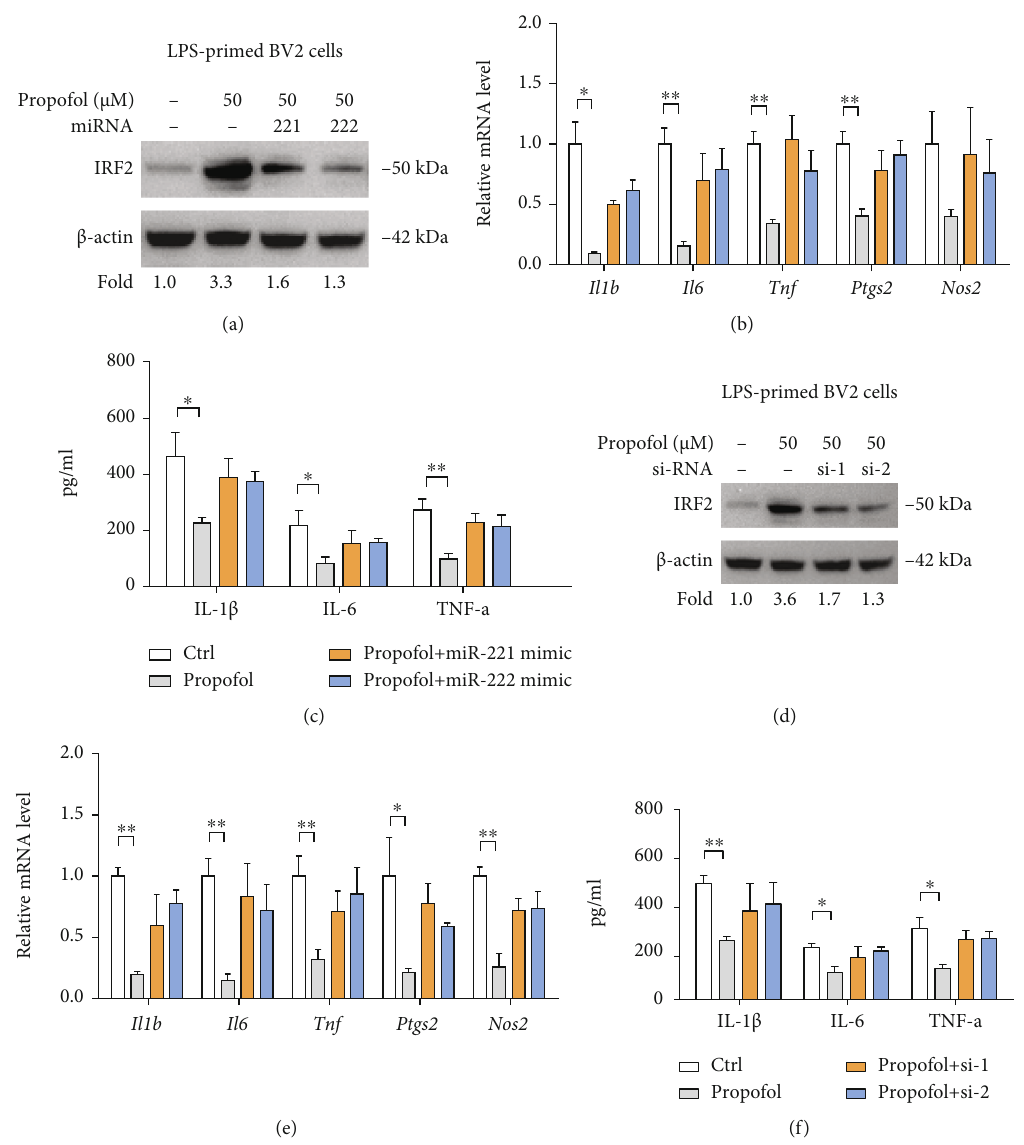
Figure 5: Propofol suppresses BV2 activation via targeting miR-221/222-IRF2 axis. (a) IRF2 protein expression in LPS-primed BV2 microglia upon treatment with propofol and/or miR-221/222 mimics was analyzed by Western blotting; β -actin was loaded as a control. (b) The e ff ects of propofol and/or miR-221/222 mimics on the mRNA expression of in fl ammatory genes ( Il1b , IL6 , Tnf , Ptgs2 , and Nos2 ) in LPS-primed BV2 cells were determined by real-time qPCR analysis ( n = 3 ). (c) The e ff ects of propofol and/or miR-221/222 mimics on the level of in fl ammatory cytokines (IL-1 β , IL-6, and TNF- α ) in conditioned medium from LPS-primed BV2 cells were analyzed by ELISA ( n = 3 ). (d) IRF2 protein expression in LPS-primed BV2 microglia upon treatment with propofol and/or siRNAs against IRF2 was analyzed by Western blotting; β - actin was loaded as a control. (e) The e ff ects of propofol and/or IRF2 siRNAs on the mRNA expression of in fl ammatory genes ( Il1b , IL6 , Tnf , Ptgs2 , and Nos2 ) in LPS-primed BV2 cells were determined by real-time qPCR analysis ( n = 3 ). (f) The e ff ects of propofol and/or IRF2 siRNAs on the level of in fl ammatory cytokines (IL-1 β , IL-6, and TNF- α ) in conditioned medium from LPS-primed BV2 cells were analyzed by ELISA ( n = 3 ). ∗ p < 0 : 05 and ∗∗ p < 0 : 01